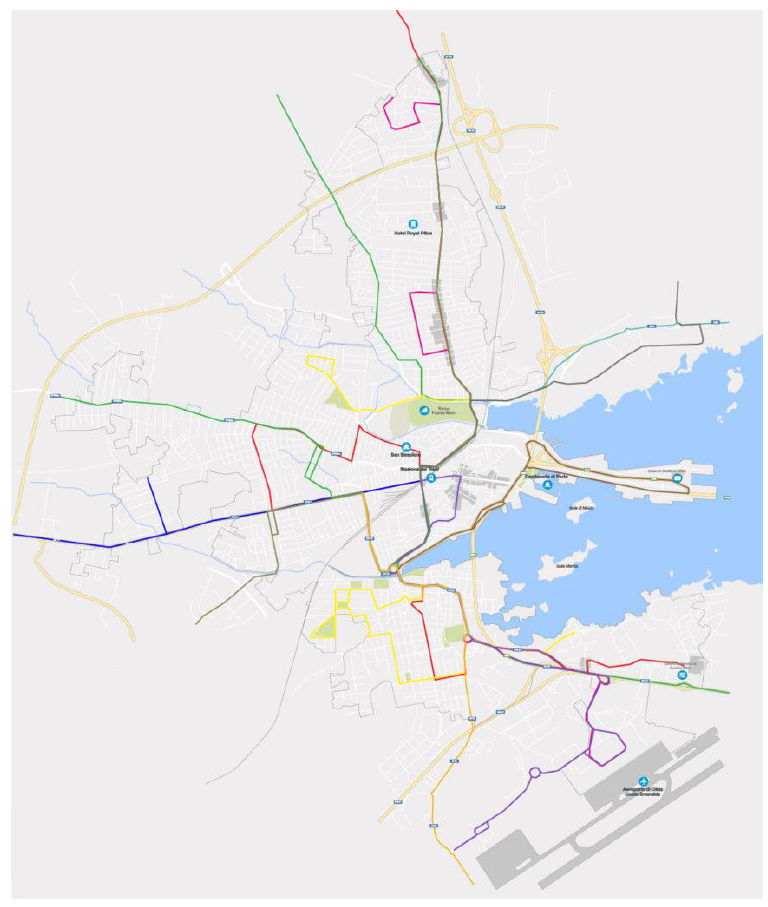
Figure 3. Olbia transit routes.